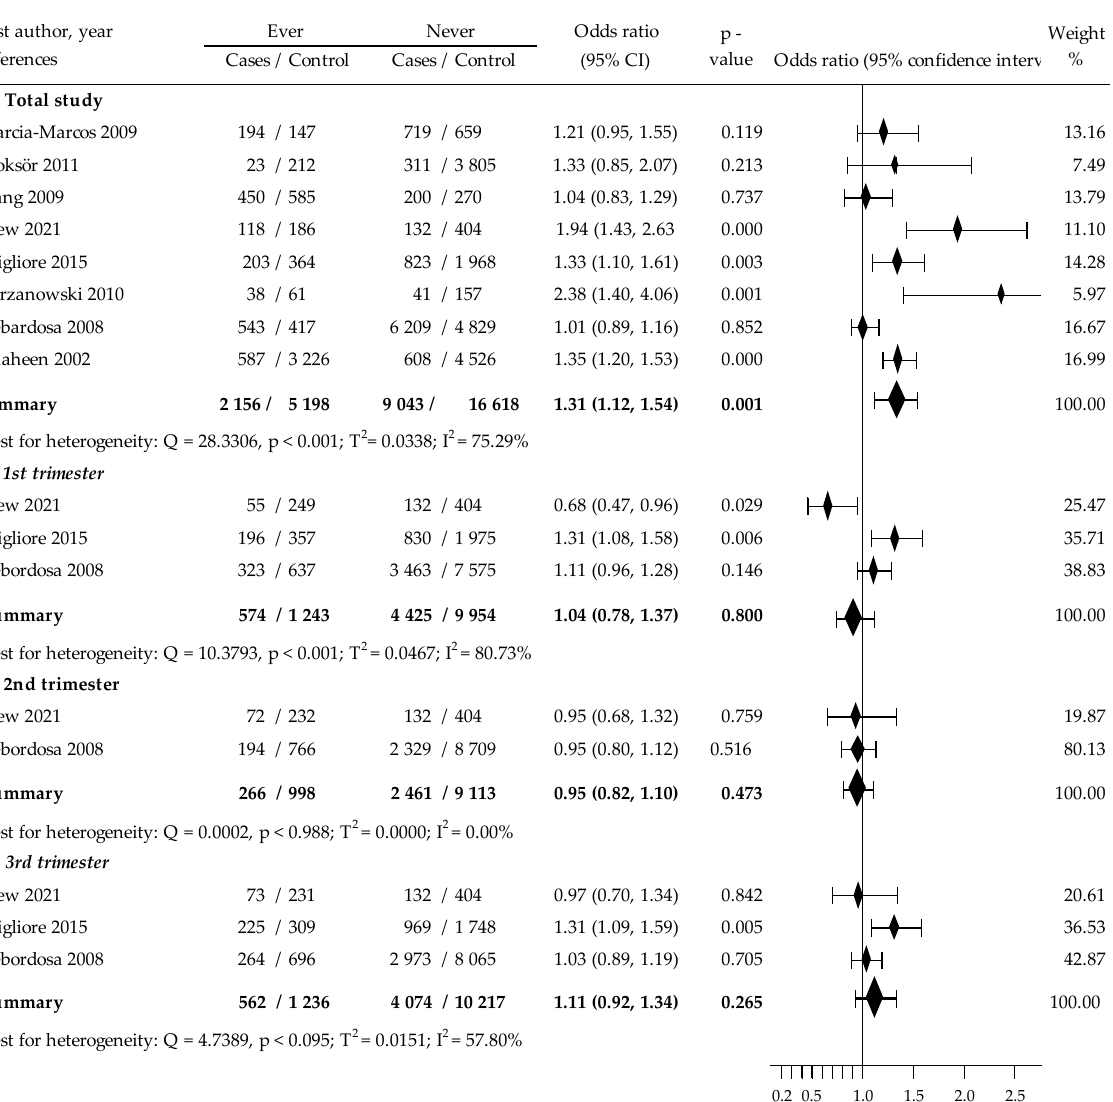
Figure 3. The crude relationship between childhood wheeze and paracetamol use (ever vs. never) during pregnancy and each trimester of pregnancy [22,26,28–33].